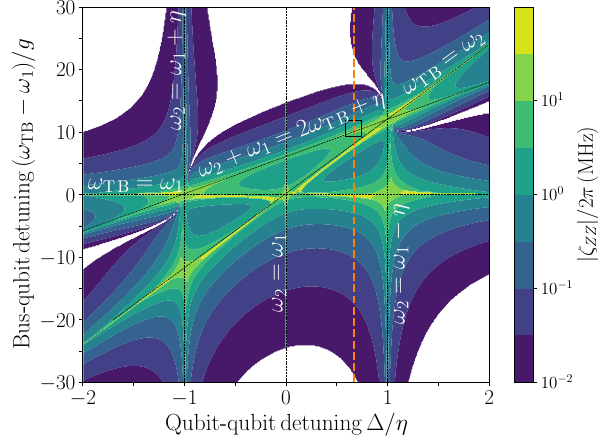
FIG. 2. ZZ coupling ζ ZZ (data points with ZZ coupling strengths below 10 kHz are removed) as a function of qubit- qubit detuning and bus-qubit detuning, where the frequency of Q 2 is fixed at ω 1 / 2 π = 5.000 GHz. Other system parameters are the same as those used in Fig. 1(c). Vertical cut (orange dashed line) denotes the result plotted in Fig. 1(c), and open black square marks the working point at ω on = ¯ ω − η TB / 2 with the mean qubit frequency ¯ ω = (ω 1 + ω 2 )/ 2.